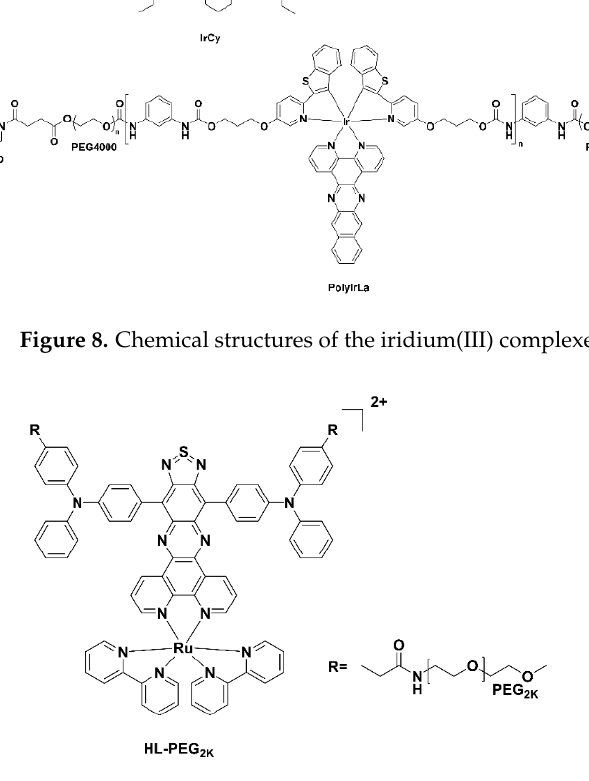
Figure 9. Chemical structure of the Ru(II) polypyridyl complex, HL-PEG 2K .